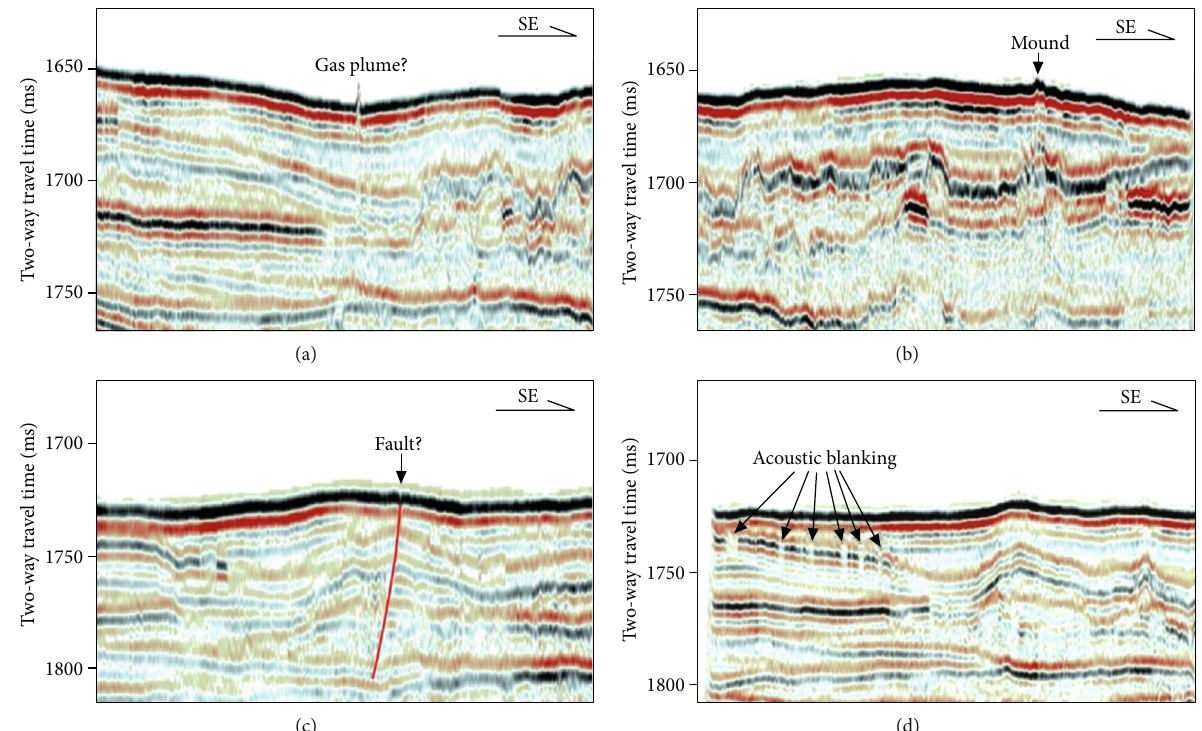
Figure 3: Seismic pro fi les showing the seabed microgeomorphological features related to gas seepage in the deep-water Qiongdongnan